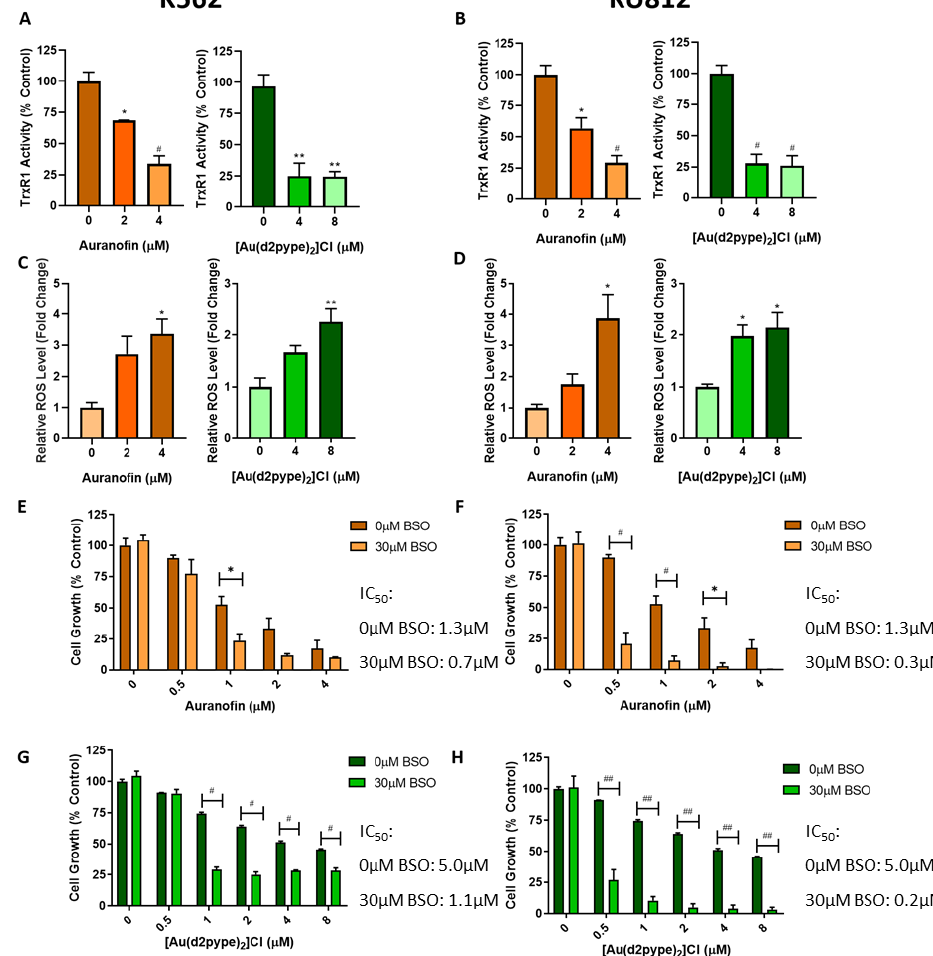
Figure 2. TrxR Inhibitors Decrease TrxR Activity and Induce Higher ROS Levels. A , B : K562 and KU812 CML cells respectively were treated with either auranofin or [Au(d2pype) 2 ]Cl for 24 h. TrxR activity was then measured using a DTNB based colourimetric assay and activity was made relative to total protein. C , D : K562 and KU812 CML cells respectively were treated with either auranofin or [Au(d2pype) 2 ]Cl for 24 h. ROS levels were then measured using a H 2 DCFDA fluorogenic assay. Results were made relative to total cell number. E – H : Both cell lines were treated with auranofin or [Au(d2pype) 2 ]Cl and with or without BSO for 24 h, following this an MTT proliferation assay was performed. Results were analysed with multiple T -tests. In figures A–D statistical tests compared results of untreated and treated cells. In figures E – H statistical tests compared cells treated with or without BSO. * = p < 0.05, ** = p < 0.01, # = p < 0.001, ## = p < 0.0001. N = 3. Values displayed as mean ± SEM.